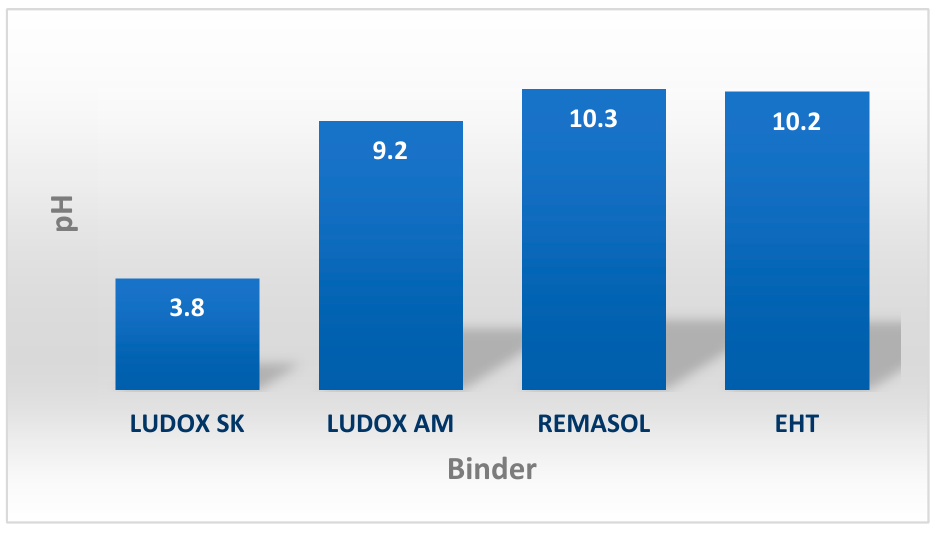
Figure 9. The reaction of selected binders based on colloidal silica.